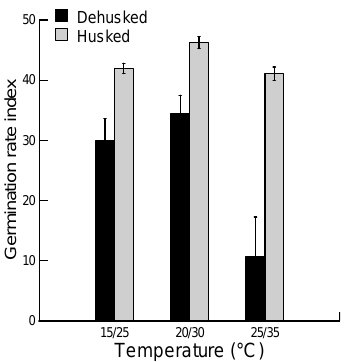
Figure 3. Effects of incubation temperature on germination rate index (mean ± SE) of husked and dehusked-demembraned grains of Brachypodium hybridum . The grains were soaked for 24 hrs before germination in three programmed growth chambers. The mean of each treatment is from four replicate dishes, each with 20 seeds.